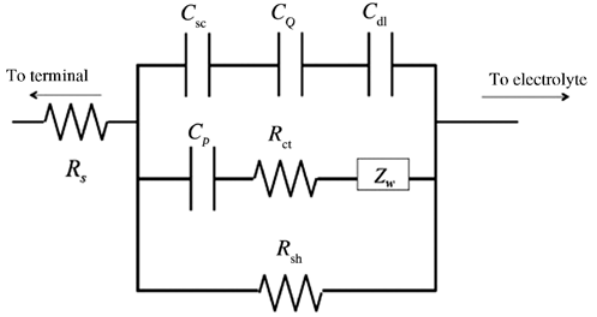
Figure 3: A possible impedance model consisting of additional resistance and capacitance contributions in 2D material that consti- tuted nanostructured electrodes. In non-metallic materials, space charge capacitance – C (see Section 2.3), quantum capacitance – sc C (see Section 2.4), in addition to a Faradaic/surface area-depend- Q ent pseudocapacitance or chemical capacitance – C (see Section p 2.5), as well as concomitant leakage/shunt resistances – R , may be sh